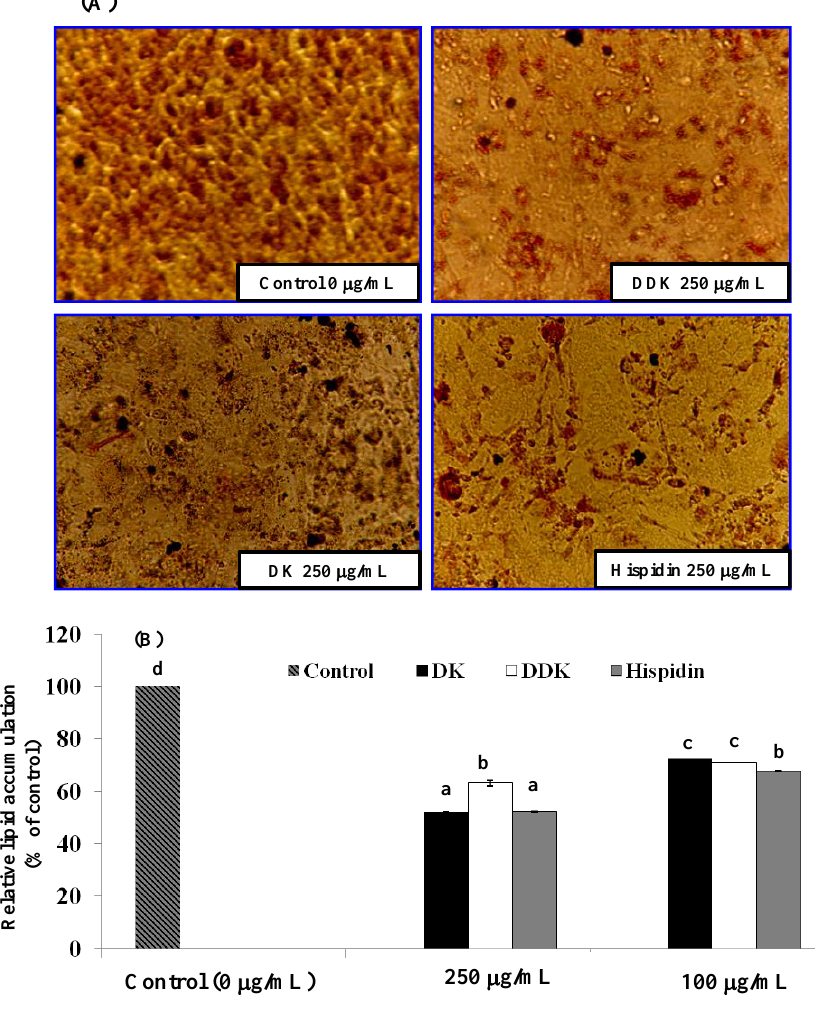
Figure 6. The effect of hispidin, DK and DDK on lipid accumulation in 3T3-L1 adipocytes. ( A ) Effects of hispidin, DK and DDK on lipid droplet formation in 3T3-L1 adipocytes assessed by staining with Oil Red O dye and visualization light microscopy. ( B ) Relative lipid content of each sample determined by quantitative analysis of Oil Red O content. Reported values are the means ± SE ( n = 3). Letters with different superscripts indicate samples that are significantly different ( p < 0.05) than the